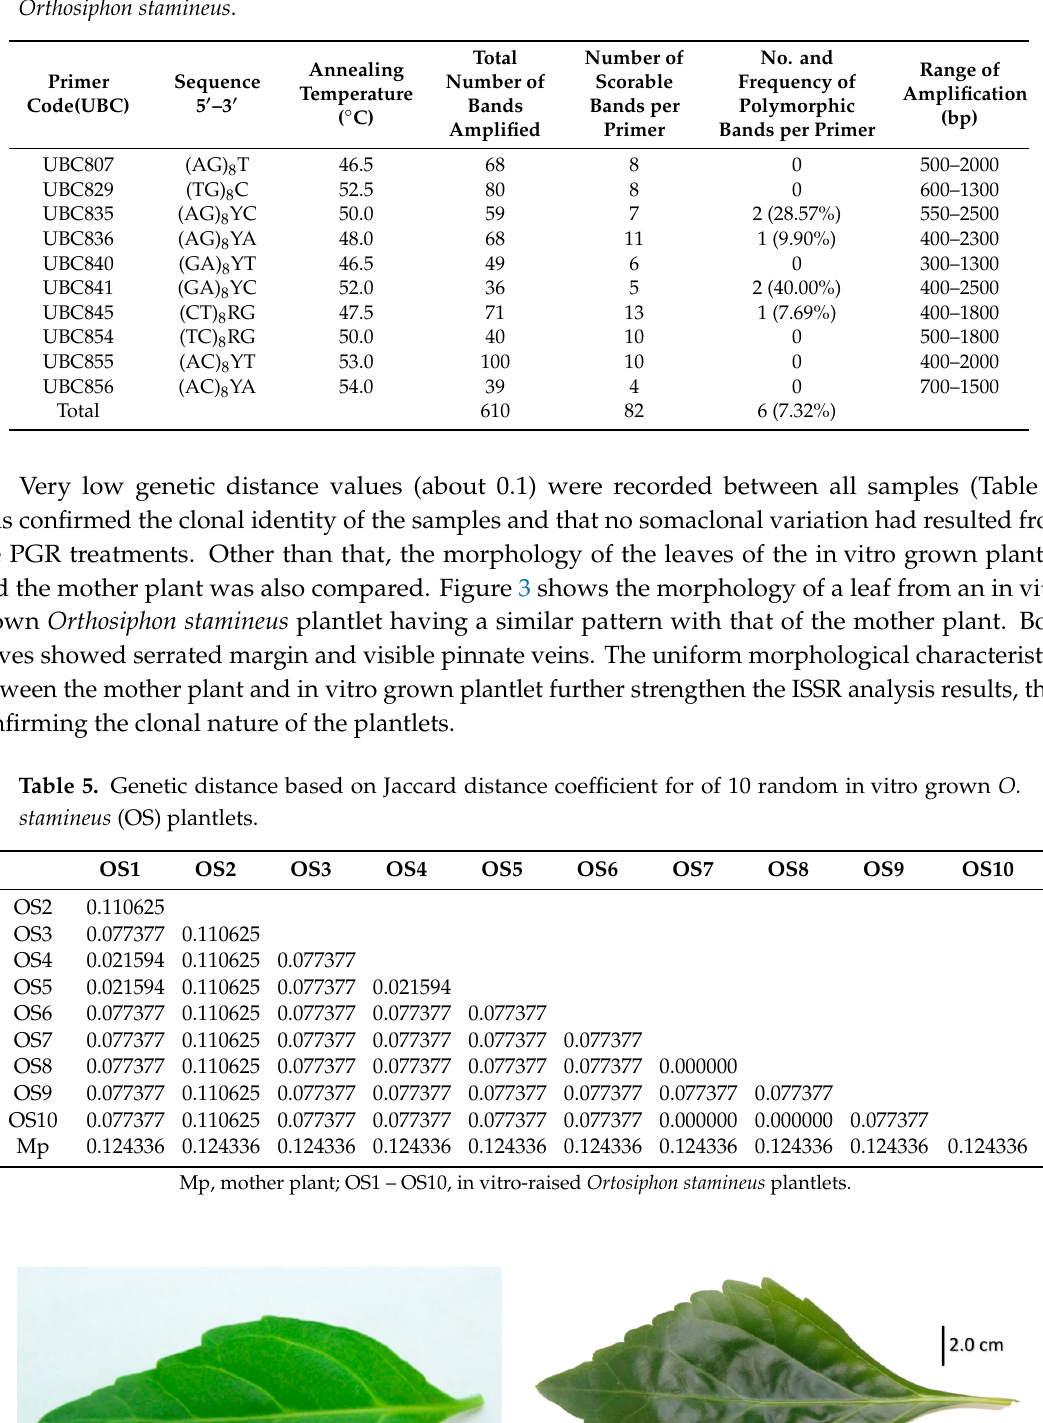
Table 4. Primer used in ISSR polymorphism analysis, number and size of amplified fragments of Orthosiphon stamineus .